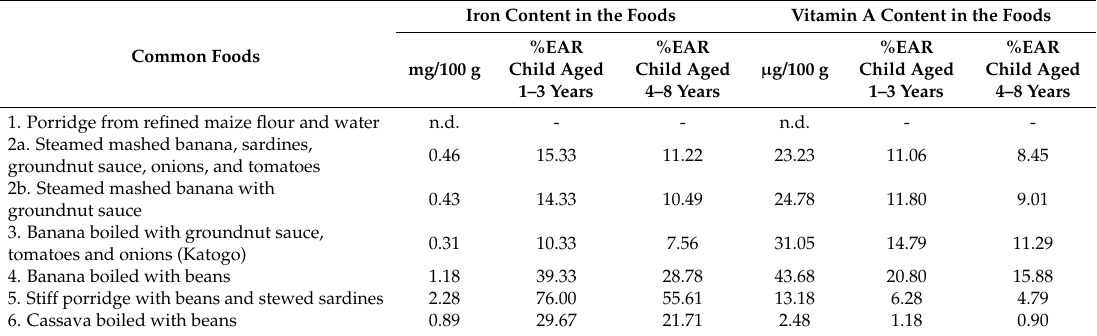
Table 4. Contribution of the common foods to iron and vitamin A estimated average requirements (EAR) for children aged 1–3 and 4–8 years based on consumption of 100 g edible portion. Iron Content in the Common Foods